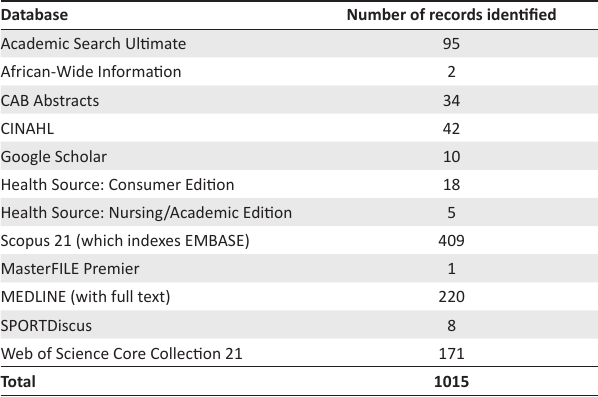
TABLE 2 : Databases searched and